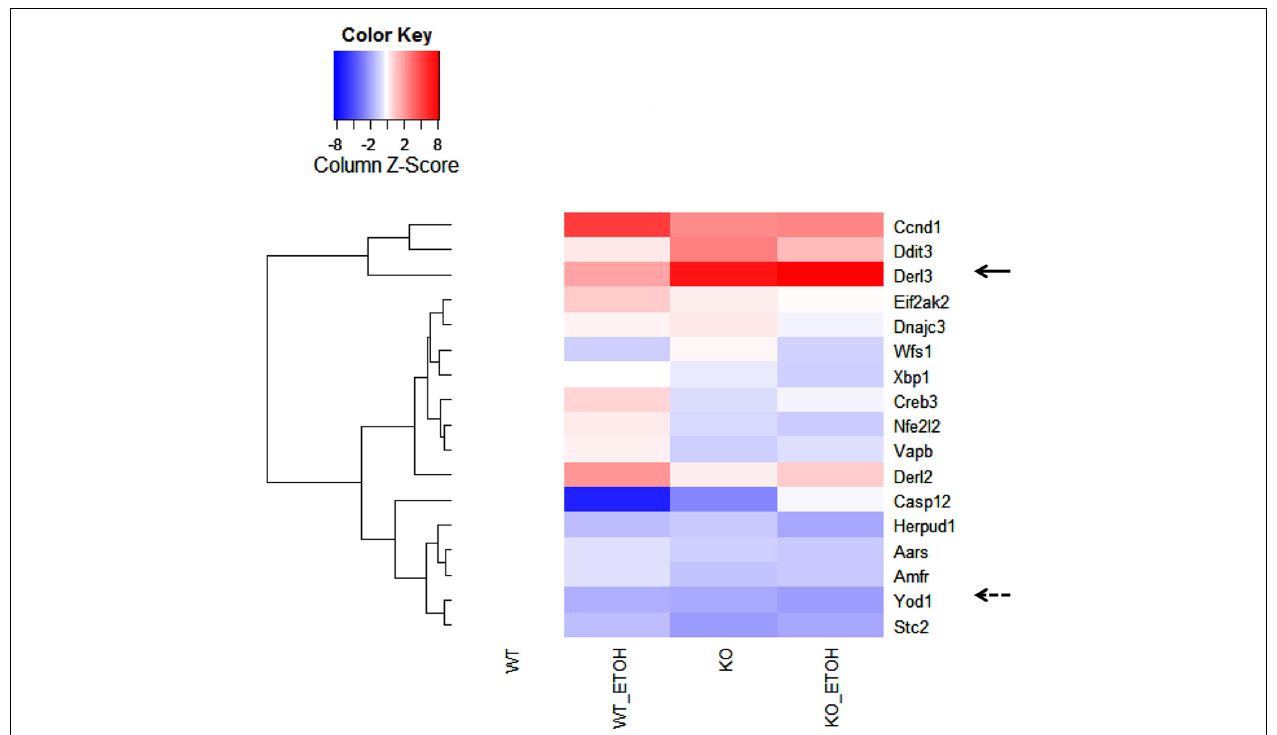
FIGURE 5 | Effects of alcohol consumption on mRNA expression of ER-associated degradation (ERAD) factors in the liver of wild type versus BiP knockout. Ccnd1, cyclin D1; Ddit3, DNA damage-inducible transcript 3, also known as C/EBP homologous protein (CHOP); Derl2 and 3, Der1p-like protein called derlin; Eif2ak2, eukaryotic translation initiation factor 2- α kinase 2; Dnajc3, DnaJ (Hsp40) homolog, subfamily C, member 3, also known as p58IPK; Wfs1, Wolfram syndrome gene; Xbp1, X-box binding protein 1; Creb3, cAMP responsive element binding protein 3;